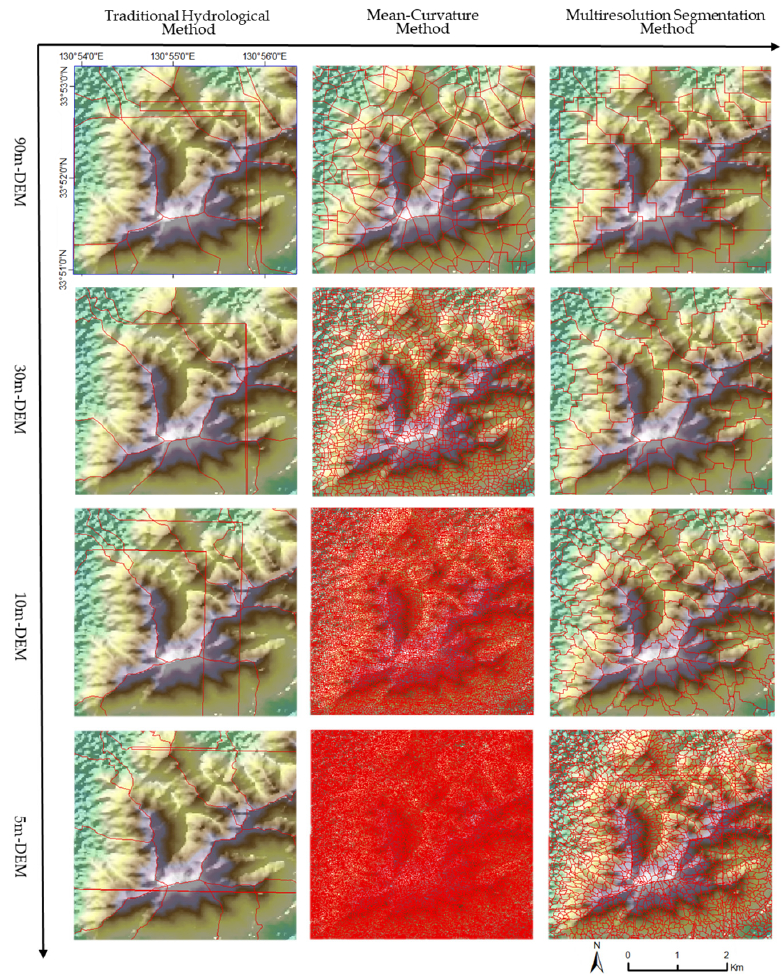
Figure 7. Comparison of the three different slope unit segmentation methods against different DEM resolutions. Details in the selected example area, as marked in Figure 5.